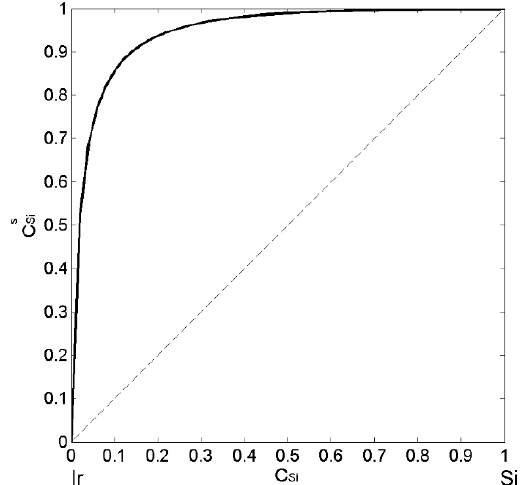
Figure 5. Surface composition ( C s ) vs. bulk composition ( C Si ) in liquid Ir-Si alloys calculated by the QCA for regular solution for T = 1873 K. (----- the additive rule).